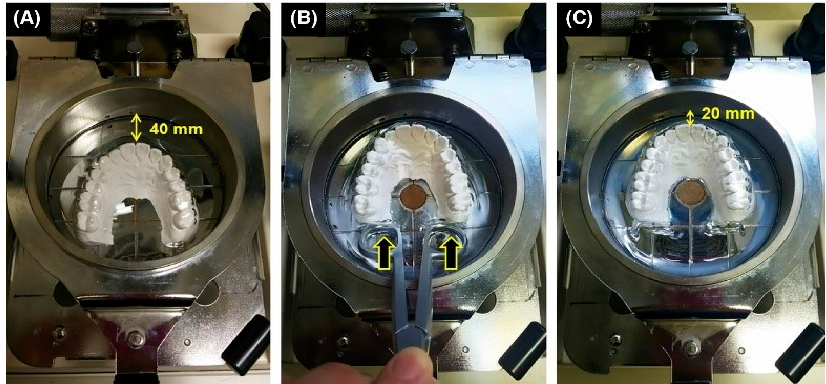
Figure 9. Pressure machine and molding condition (condition MP). The sheet frame at the top of the post was lowered, and the sheet covered the model when it sagged by 15 mm. The rear side of the model was pushed to move the model forward 20 mm, and then, the sheet was formed [110]. Copyright Wiley-VCH Verlag GmbH & Co. KGaA. Reproduced with permission.